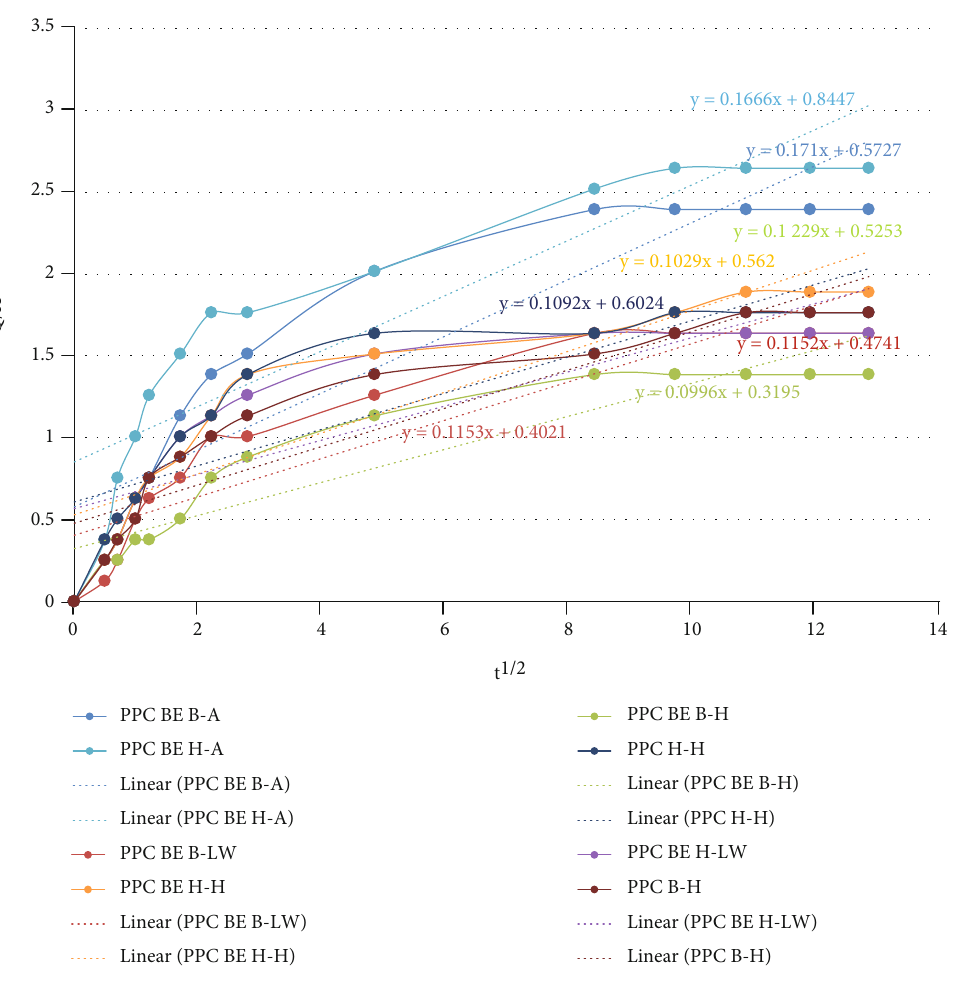
Figure 6: Sorptivity coe ffi cients for PPC test mortar prisms cured for 28